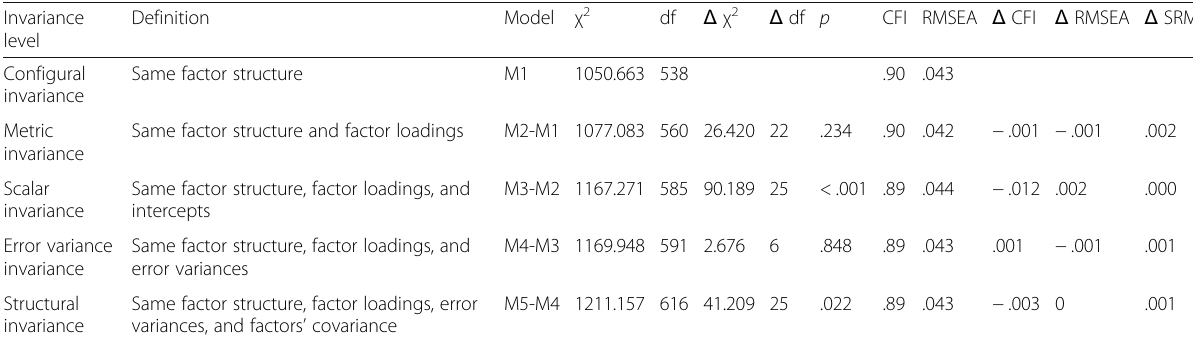
Table 7 Models ’ comparison for invariance tests for URS for gender invariance (subsample from samples CFA1 and CFA2: N = 520; 268 females; 252 males)